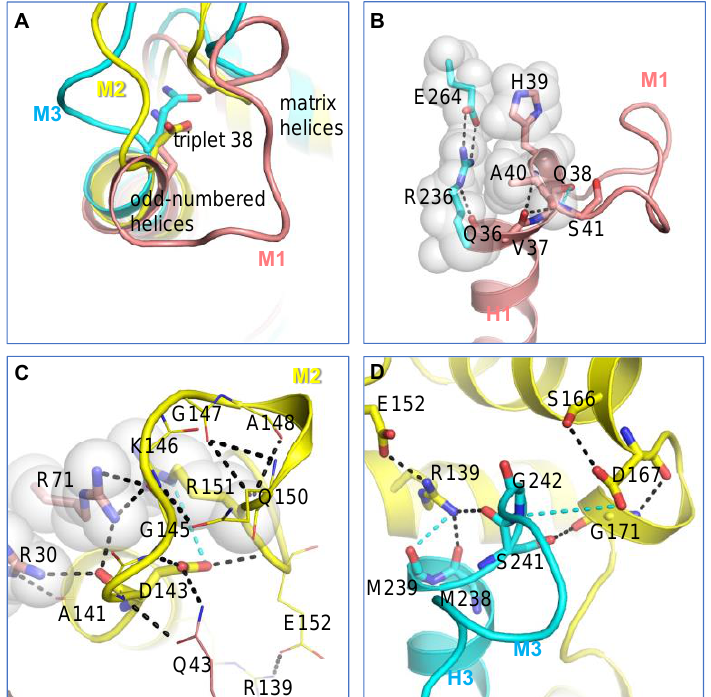
Figure 4. The determinants of the initial progression direction of the matrix loops of AAC. ( A ) Super- imposed structures of the three domains to highlight the different progression directions of the three matrix loops. Residues of triplet 38 are presented in stick mode. Detailed interactions in domain 1, domain 2 and domain3 are shown in ( B – D ), respectively. Residues that cause steric hindrance ( B ) or form a stacking structure ( C ) are also shown as transparent spheres. In ( A – D ), the structures of domains 1, 2 and 3 are shown in salmon, yellow and blue,